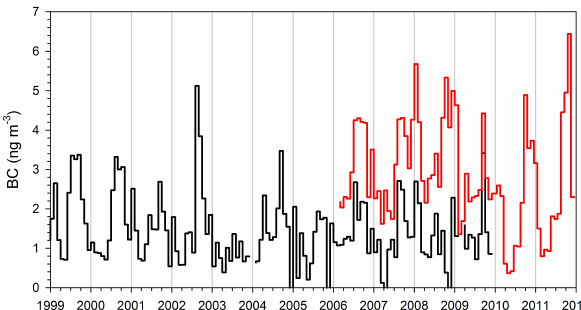
Fig. 2. Complete BC time series based on monthly means. The black and red line represents the data measured by the AE10 and the MAAP, respectively.